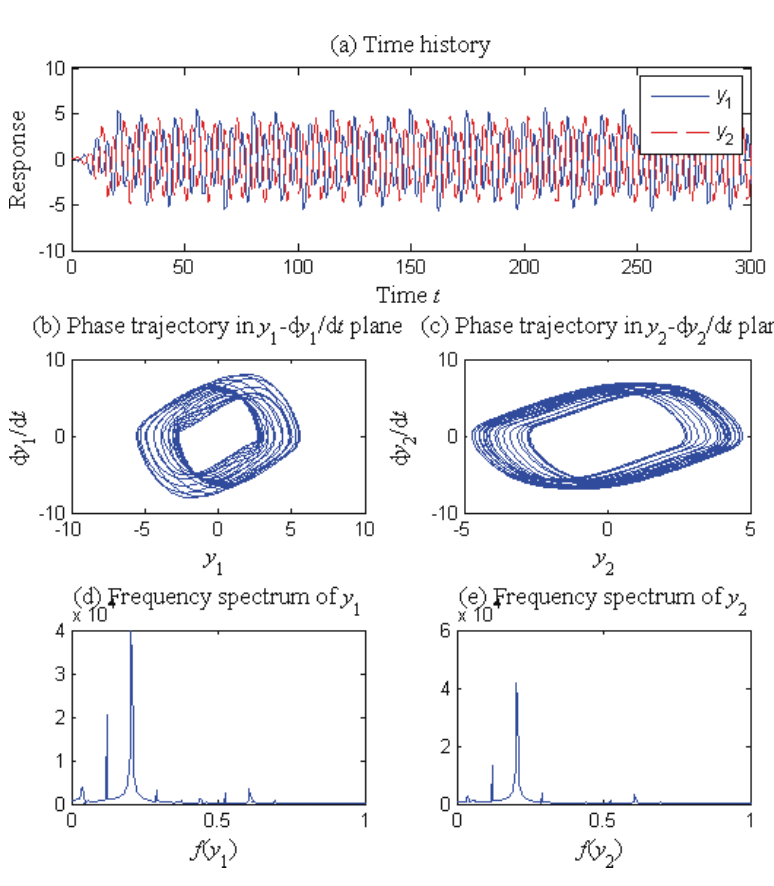
Fig. 18. Case with velocity feedback only, ( y 1 ,y 2 , ˙ y 1 , ˙ y 2 ) = (0.1,0.1,0,0).